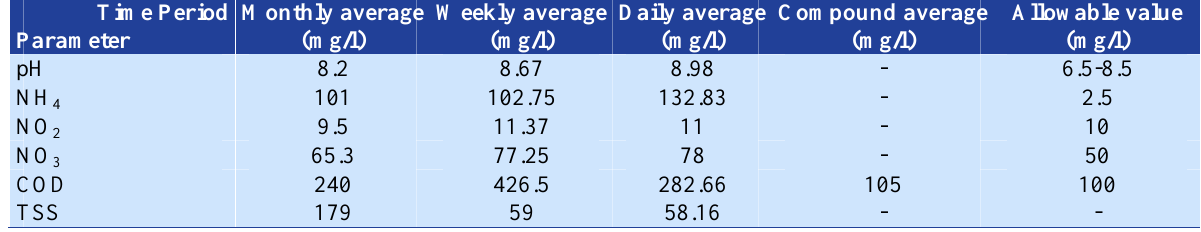
Table 1. Average values of effluent qualitative parameters Time Period